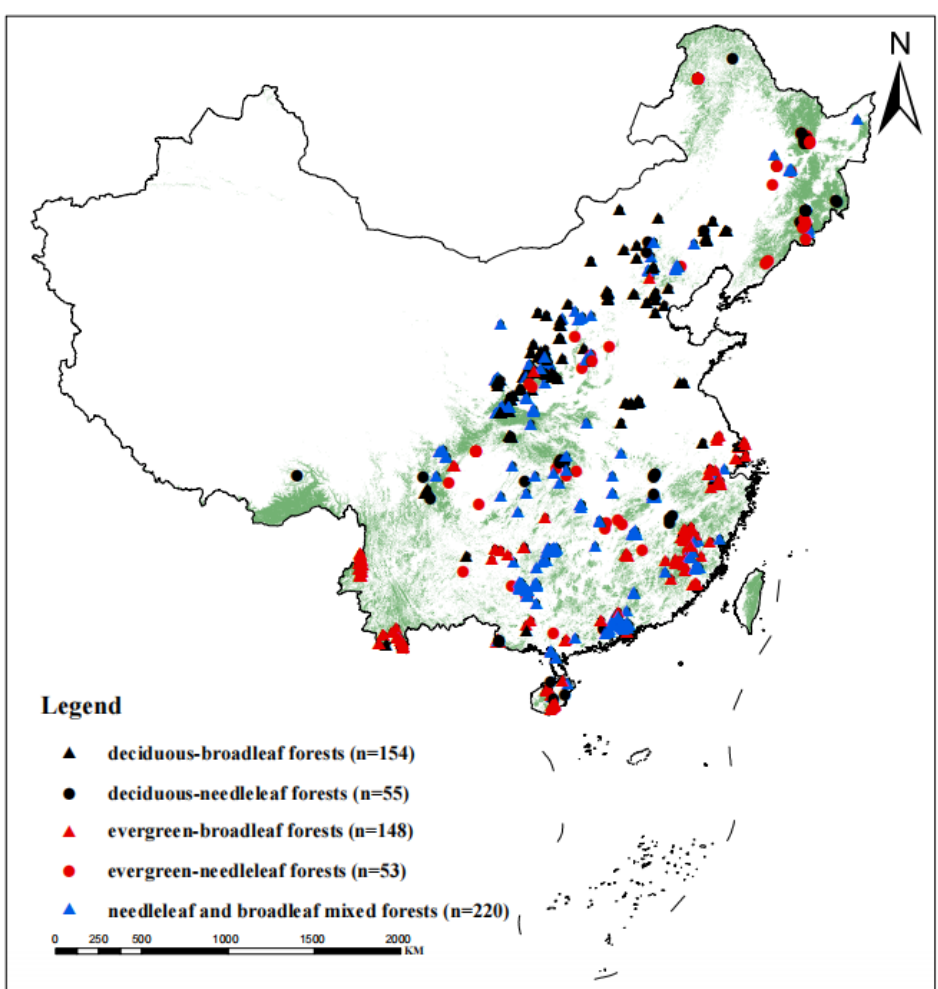
Figure 1. The distributions of forest sites, including the forest distribution according to MODIS land cover.